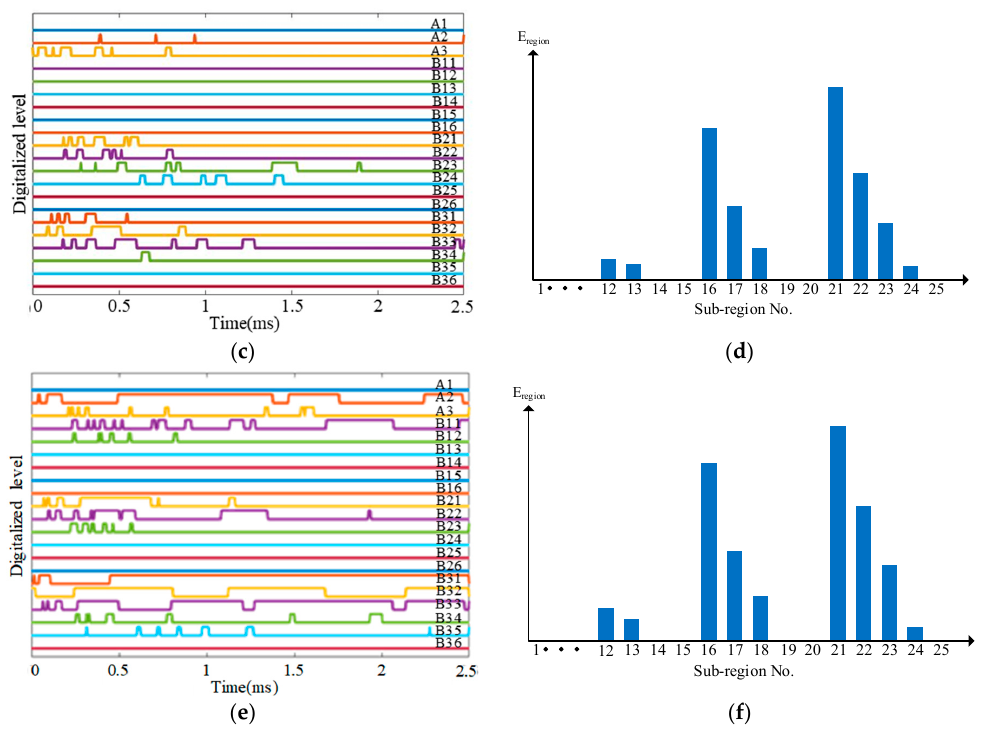
Figure 27. Typical impact region monitoring results on the UAV composite skin based on CHSN under different energy levels: ( a ) CDSs and ( b ) E region of all sub-regions under energy level 1; ( c ) CDSs and ( d ) E region of all sub-regions under energy level 2; ( e ) CDSs and ( f ) E region of all sub-regions under energy level 3. Table 4. The number of actual impacts and monitoring results.